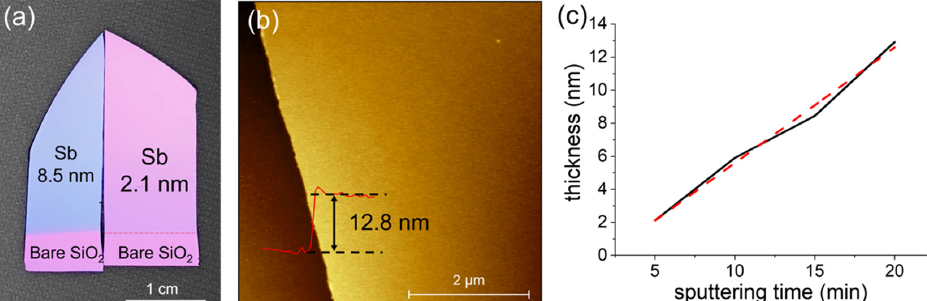
Figure 1. ( a ) Optical image of the Sb nanofilms deposited on SiO 2 /Si substrates for different durations (left piece: 15 min; right piece: 5 min) at room temperature. ( b ) Atomic force microscopic characteri-